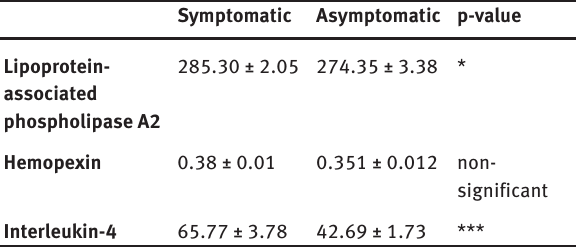
Table 3 : Plasma levels of biomarkers in correlation with the neurological